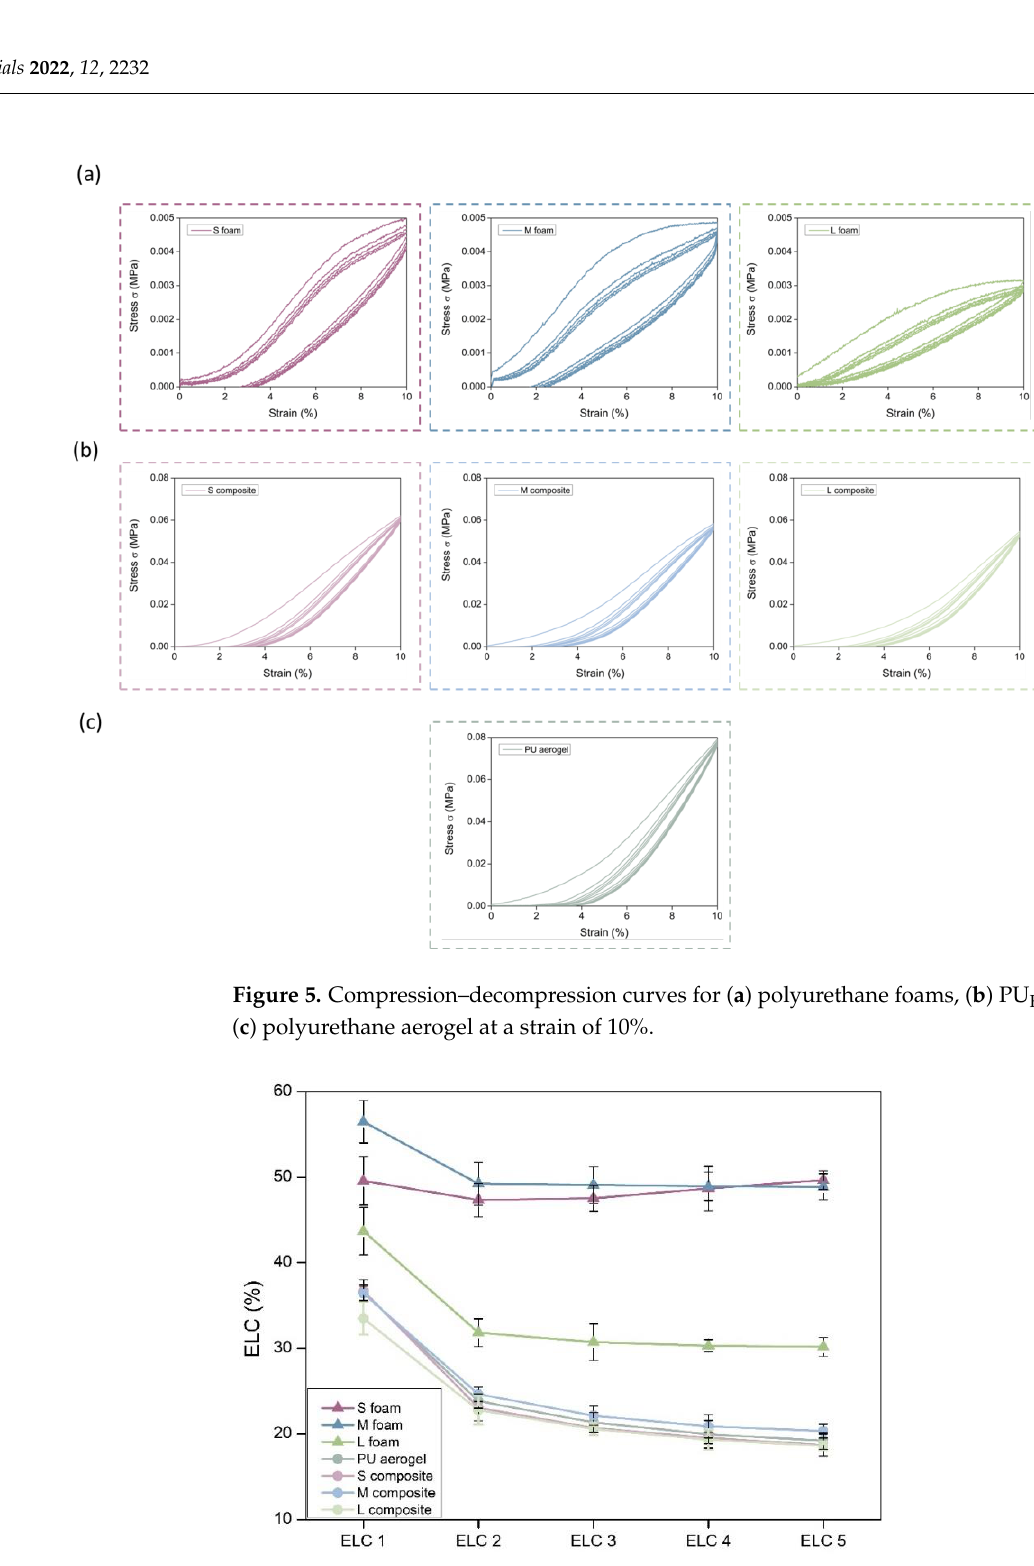
Figure 6. ELC graph the produced samples.